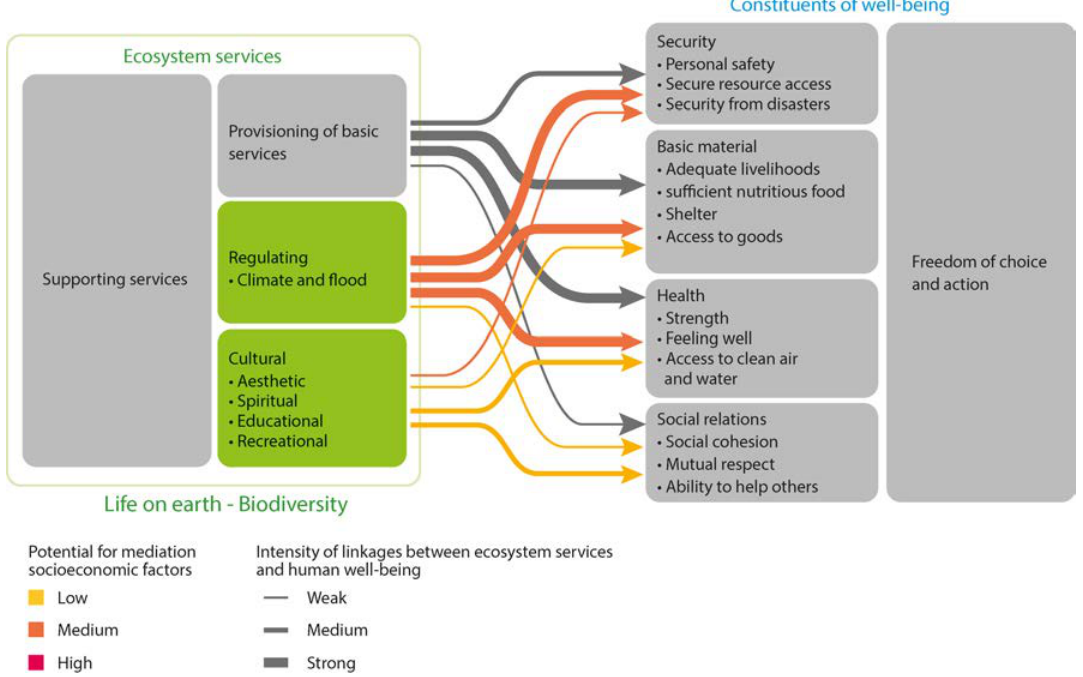
Figure 3. Linkages between ecosystem services and constituents of well-being (after [18]).